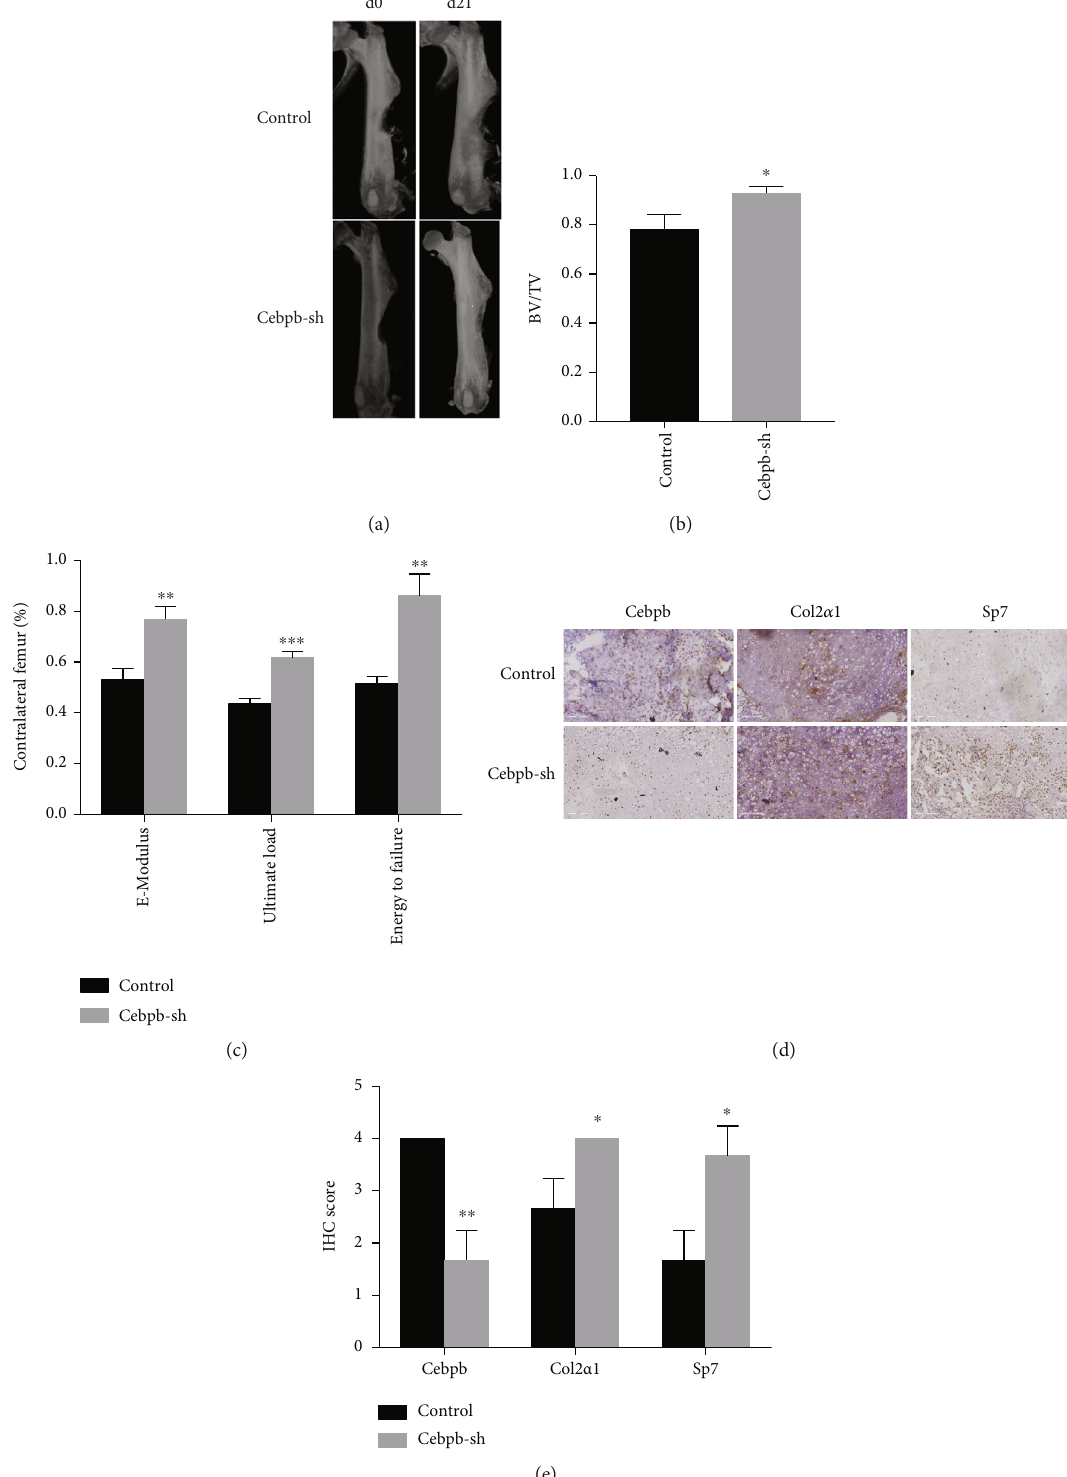
Figure 5: Cebpb knockdown accelerated fracture healing. (a) Representative micro-CT 3D reconstruction pictures in the control and Cebpb-sh groups. (b) Quanti fi cation of BV/TV of result (a). (c) Biomechanical test of injured femur compared with contralateral limbs. (d) Representative IHC pictures of monocortical defect tissues in the control and Cebpb-sh groups (200x). Scale bar: 100 μ m. (e) Quanti fi cation of IHC scores of result (d). BV: bone volume; TV: total volume. ∗ p < 0 : 05 , ∗∗ p < 0 : 01 , and ∗∗∗ p < 0 : 001